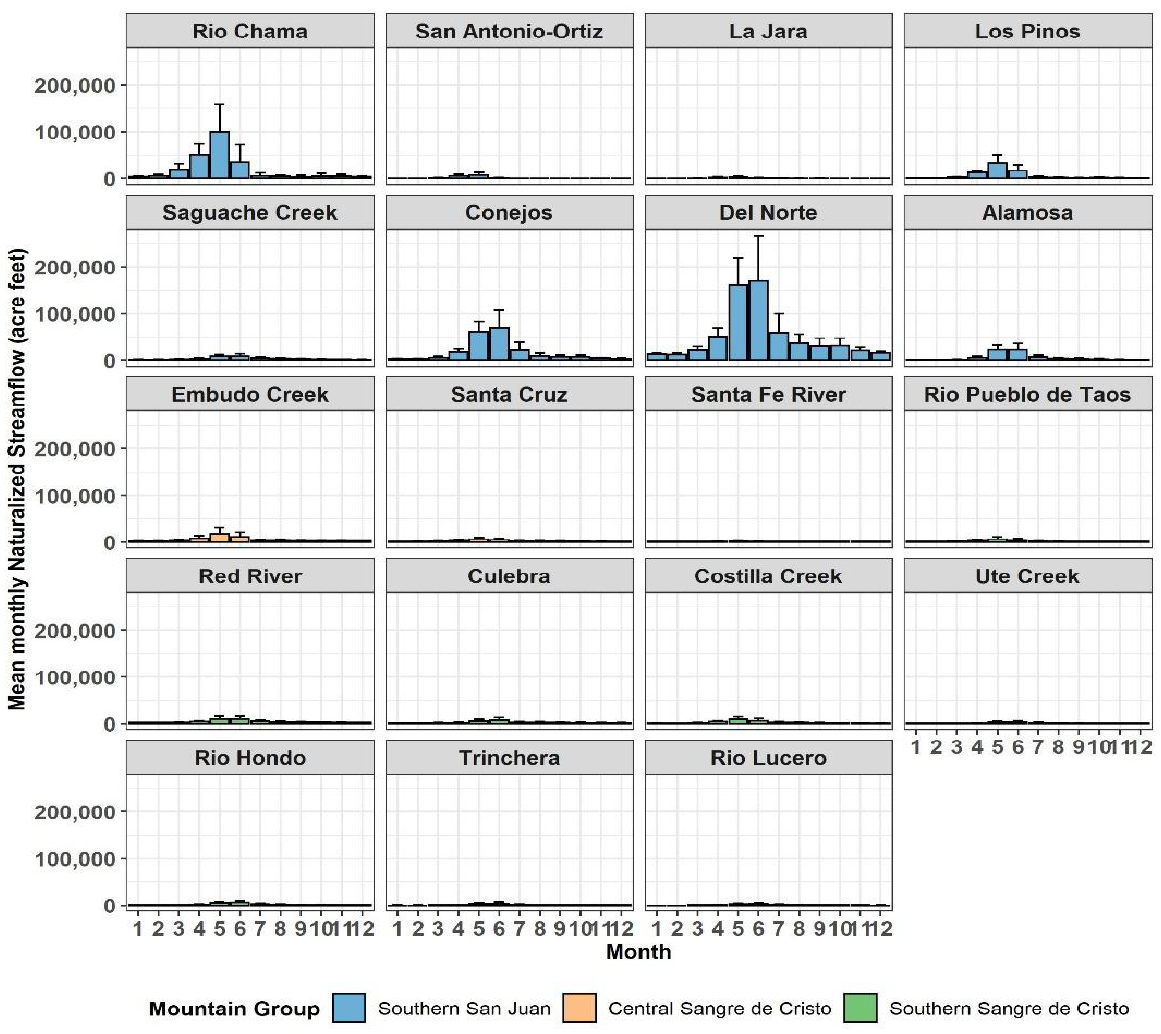
Figure A1. Monthly Mean Naturalized Streamflow.